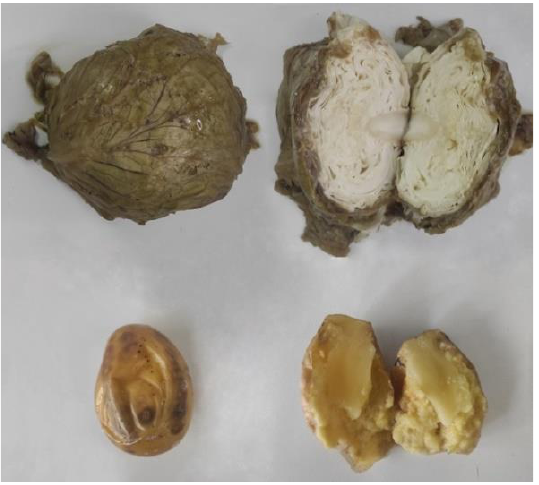
Figure 3. Examples of the bacterial soft rot symptoms on the cabbage head and potato tuber that were observed seven days after inoculation with the Serbian P. versatile strain Pv6321 and the P. carotovorum strain Pc3821,